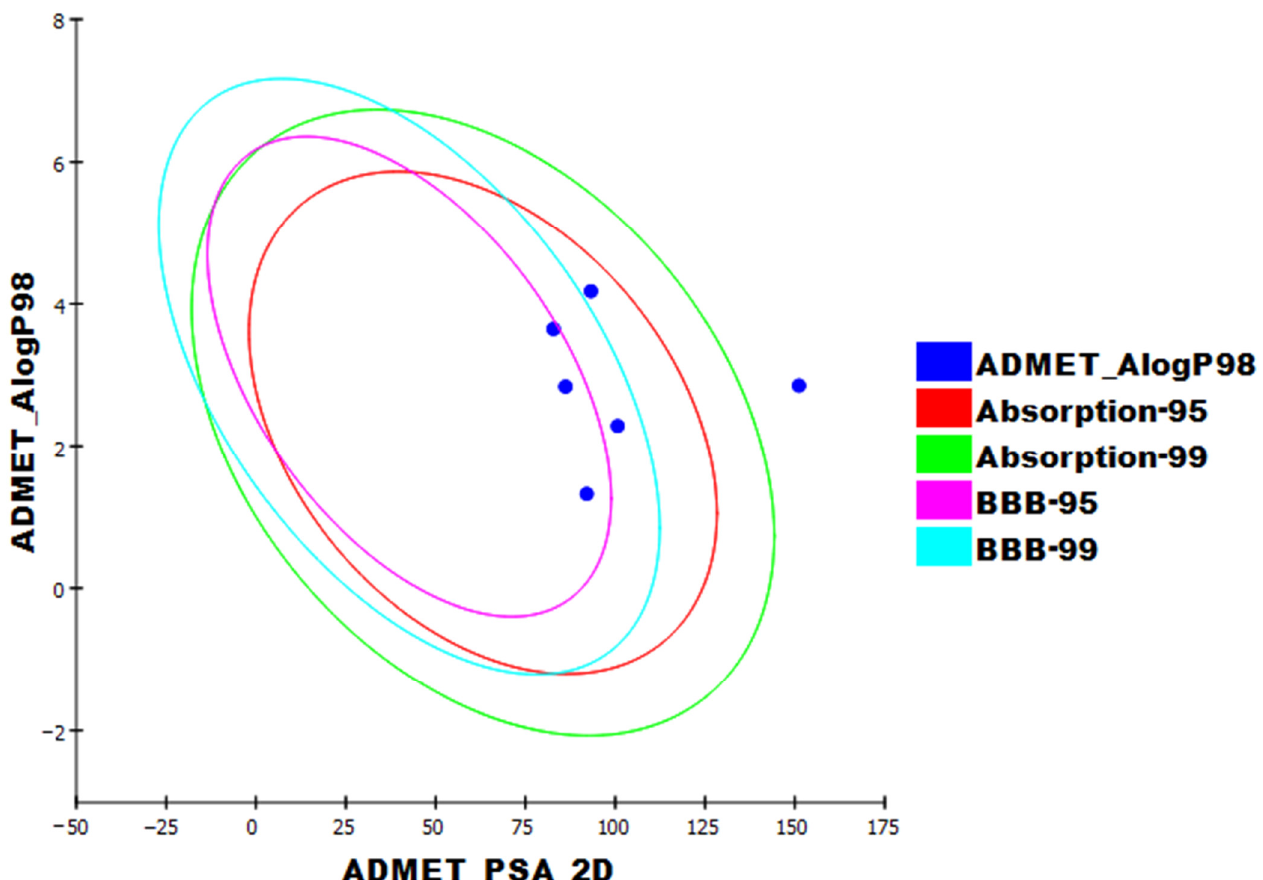
Figure 9. The predicted ADMET parameters. ADMET_PSA_2D is the polar molecular surface area. ADMET_AlogP98 is the lipid-water partition coefficient. PSA_2D is 2D polar surface area. Each examined compound is plotted against the calculated atom-type partition coefficient (ALogP98). The area enclosed by the ellipse constitutes good absorption without violation of other ADMET features. Based on Egan et al.’s [48] absorption, the 95% and 99% confidence limits’ ellipses corresponding to the BBB and intestinal absorption models are demonstrated. Table 8. In silico ADMET features of the considered compounds and sorafenib. Comp. BBB Level a